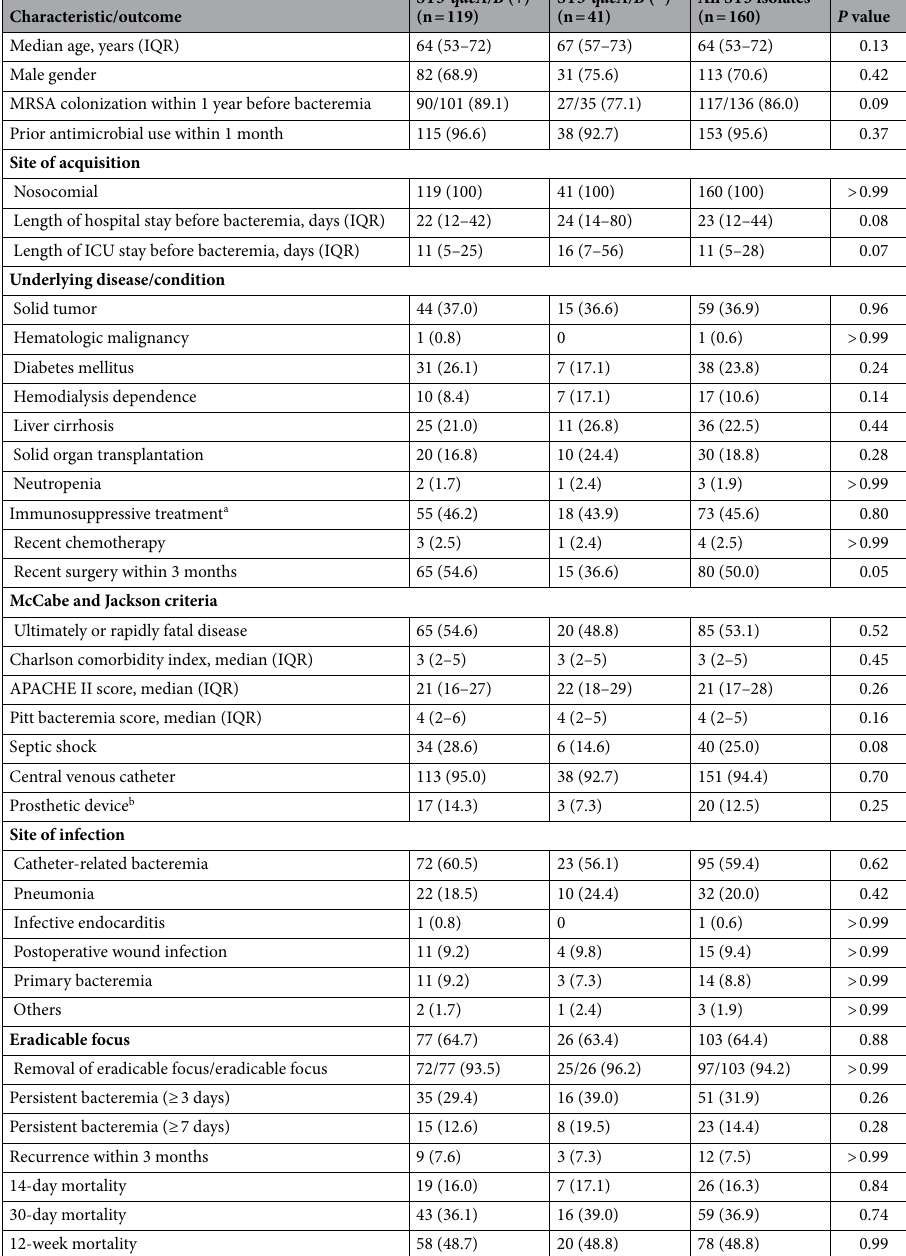
Table 1. Clinical characteristics and outcomes of patients with ST5-MRSA-II bacteremia according to qacA/B status. Data are no. (%) of patients, unless otherwise indicated. ICU intensive care unit, IQR interquartile range, MRSA methicillin resistant Staphylococcus aureus , NA not applicable, SD standard deviation. a Immunosuppressive treatment includes immunosuppressant use (≥ 7 days), steroid use (≥ 14 days), or radiation therapy (within 1 month). b Prosthetic devices include pacemaker, ICD defibrillator, prosthetic heart valves, vascular grafts, orthopedic devices, and major artery